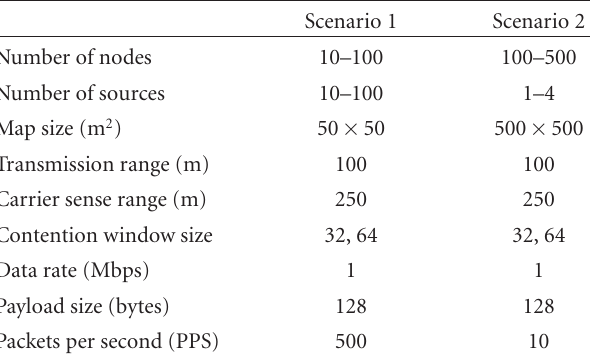
Table 1: Parameters used in the ns2